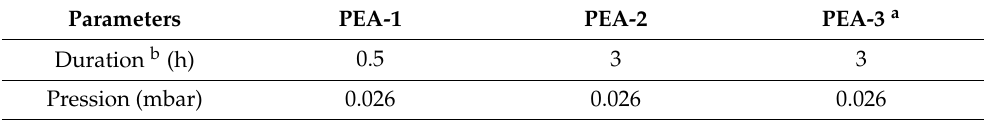
Table 1. Experimental conditions and molecular characteristics of the obtained di-hydroxylated